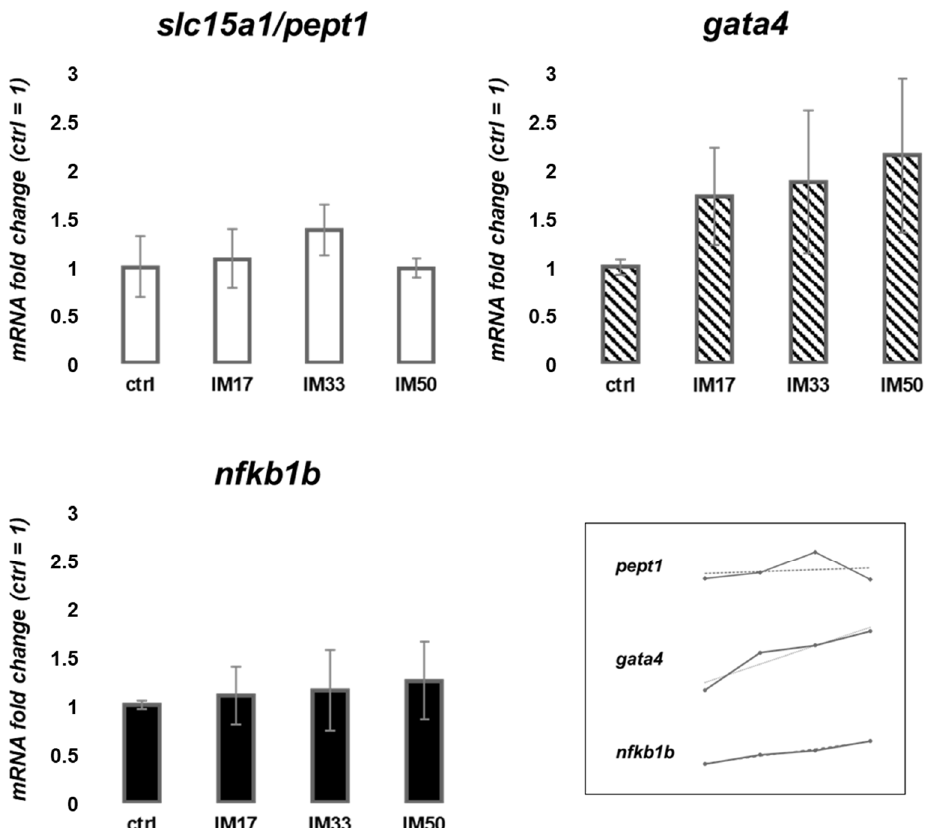
Figure 2. Expression analysis by qPCR of the slc15a1 / pept1 , gata4 and nfkb1b genes in the intestine tissues of zebrafish fed IM17, IM33 and IM50 diets. The amounts of target mRNAs ( y -axis) are reported as 2 −Δ CT mean values ± SEM [33] after normalization with respect to the housekeeping 28S rRNA, then expressed as fold-change relative to the control diet (ctrl = 1). Data refer to the mean values of n = 16 intestines from fish for each dietary treatment. Statistical analysis by ONE-WAY ANOVA and Bonferroni post-hoc test. The inbox figure summarizes the linear trend of the mRNA expression analysis for the three investigated genes.